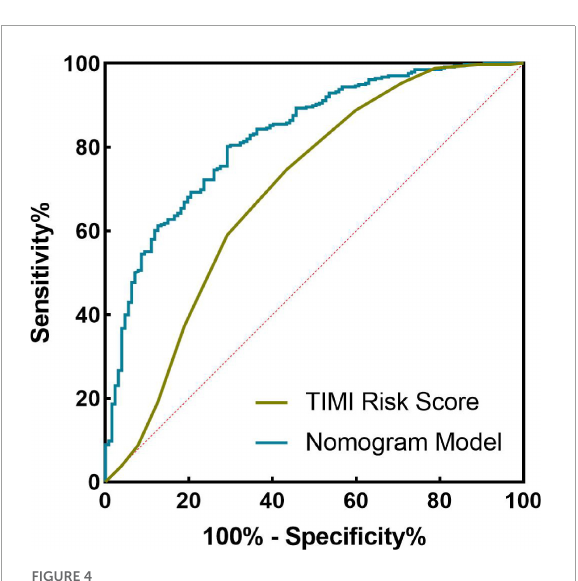
FIGURE4 Receiver operating characteristic (ROC) curve of nomogram model and thrombolysis in myocardial infarction (TIMI) score in predicting the efficacy of in-hospital major adverse cardiovascular events (MACE) after percutaneous coronary intervention (PCI) in ST-segment elevation myocardial infarction (STEMI)